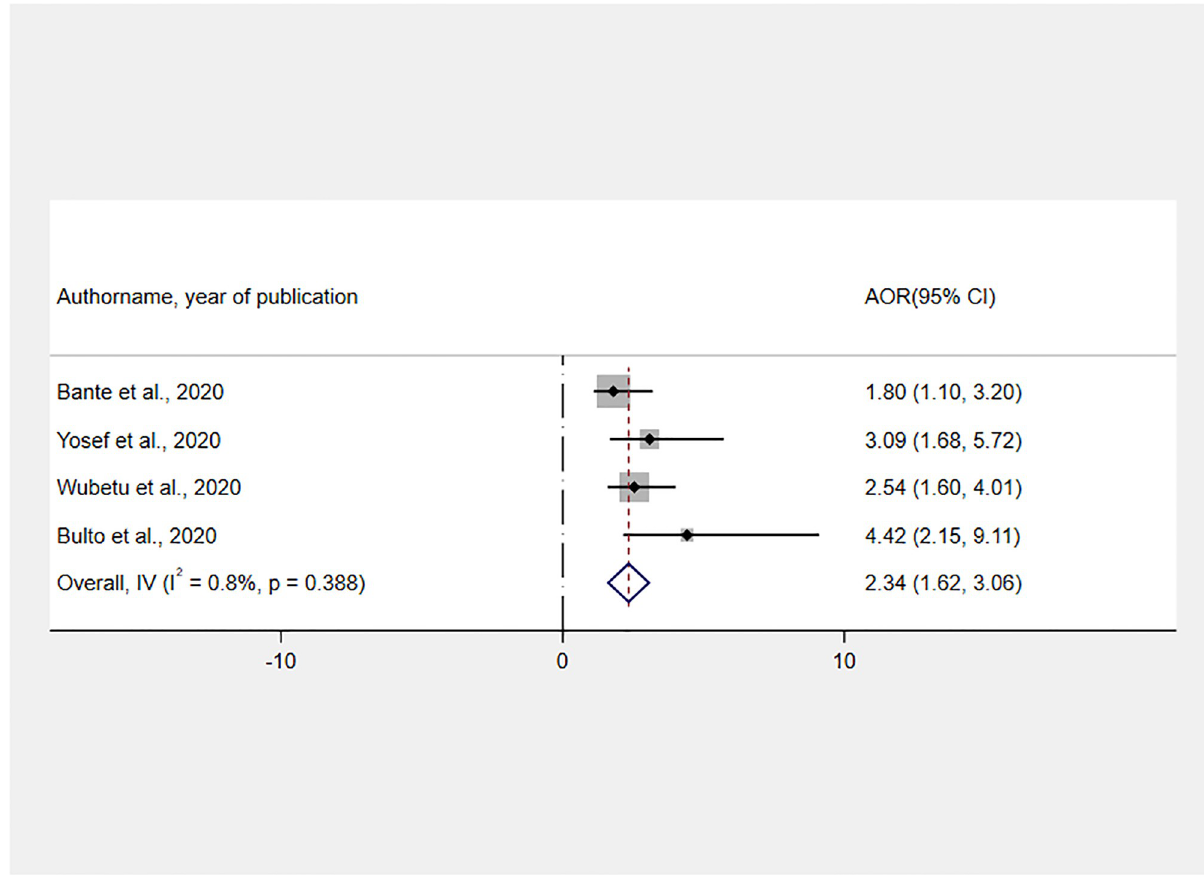
Fig 8. Forest plot showing the association between ANC and RMC during childbirth in Ethiopia,